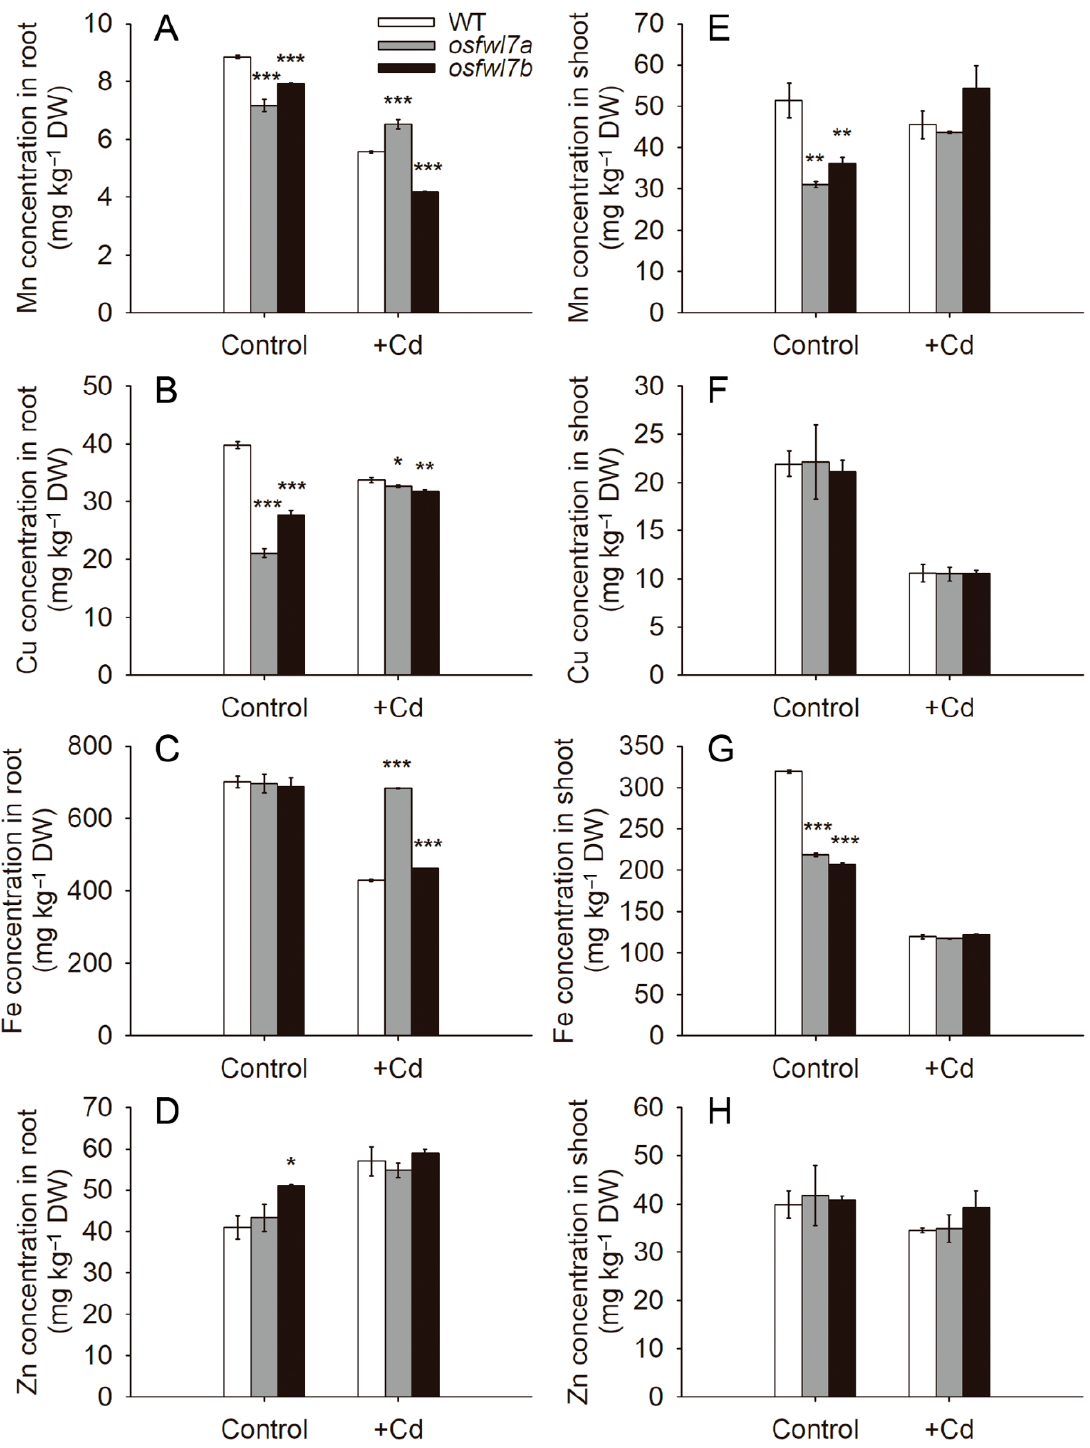
Figure 4. Effect of the osfwl7 mutation on micronutrient metal accumulation. ( A – D ) Measurement of Mn ( A ), Cu ( B ), Fe ( C ), and Zn ( D ) levels in roots of the wildtype (WT) and mutants grown under normal conditions and in the presence of 50 µ M Cd for 10 days. ( E – H ) Measurement of Mn ( E ), Cu ( F ), Fe ( G ), and Zn ( H ) levels in the shoots of WT and mutants. Error bars indicate the standard deviation of three biological replicates. * p < 0.05, ** p < 0.01, *** p < 0.001.